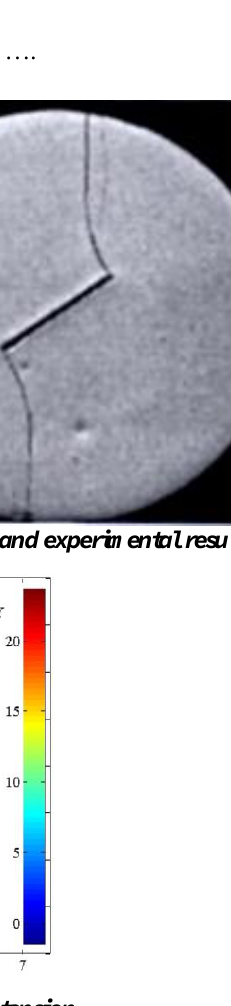
Figure 9. 45 degrees slanted center crack under